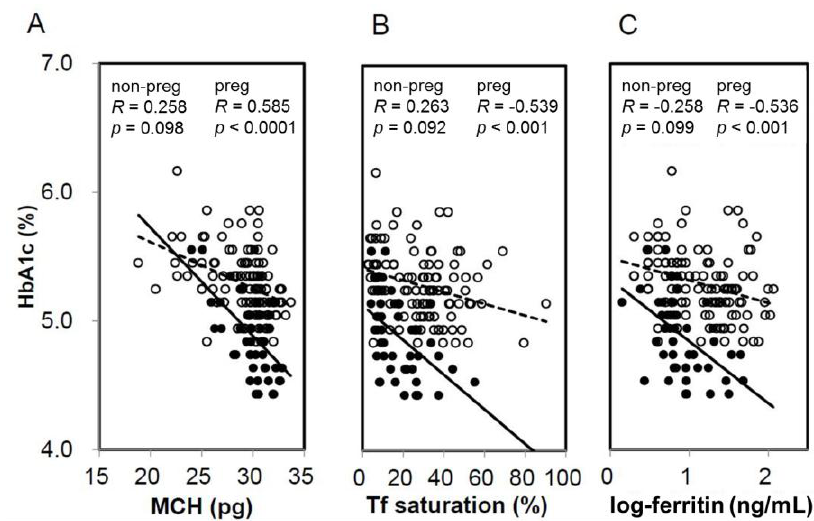
Figure 2. Correlation between iron-related parameters and HbA1c in non-pregnant and pregnant women. Correlation was shown between MCH ( A ), transferrin (Tf) saturation ( B ), and logarithm-transformed ferritin ( C ) and HbA1c in non-pregnant (open circles, dotted line) and pregnant women (closed circles, straight line). non-preg, non-pregnant women; preg, pregnant women.